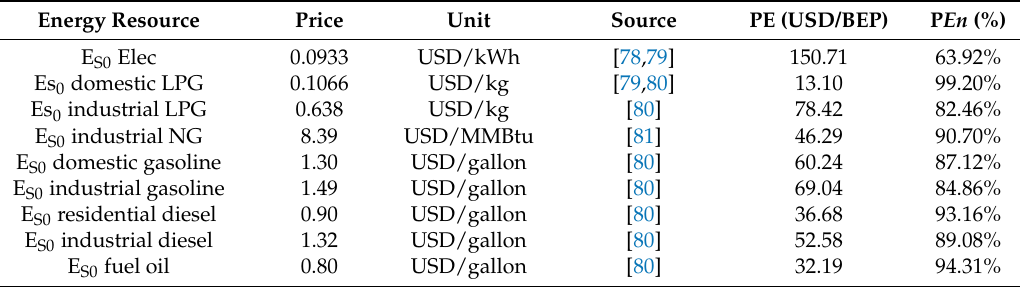
Table 14. The price of energy resources in Ecuador.